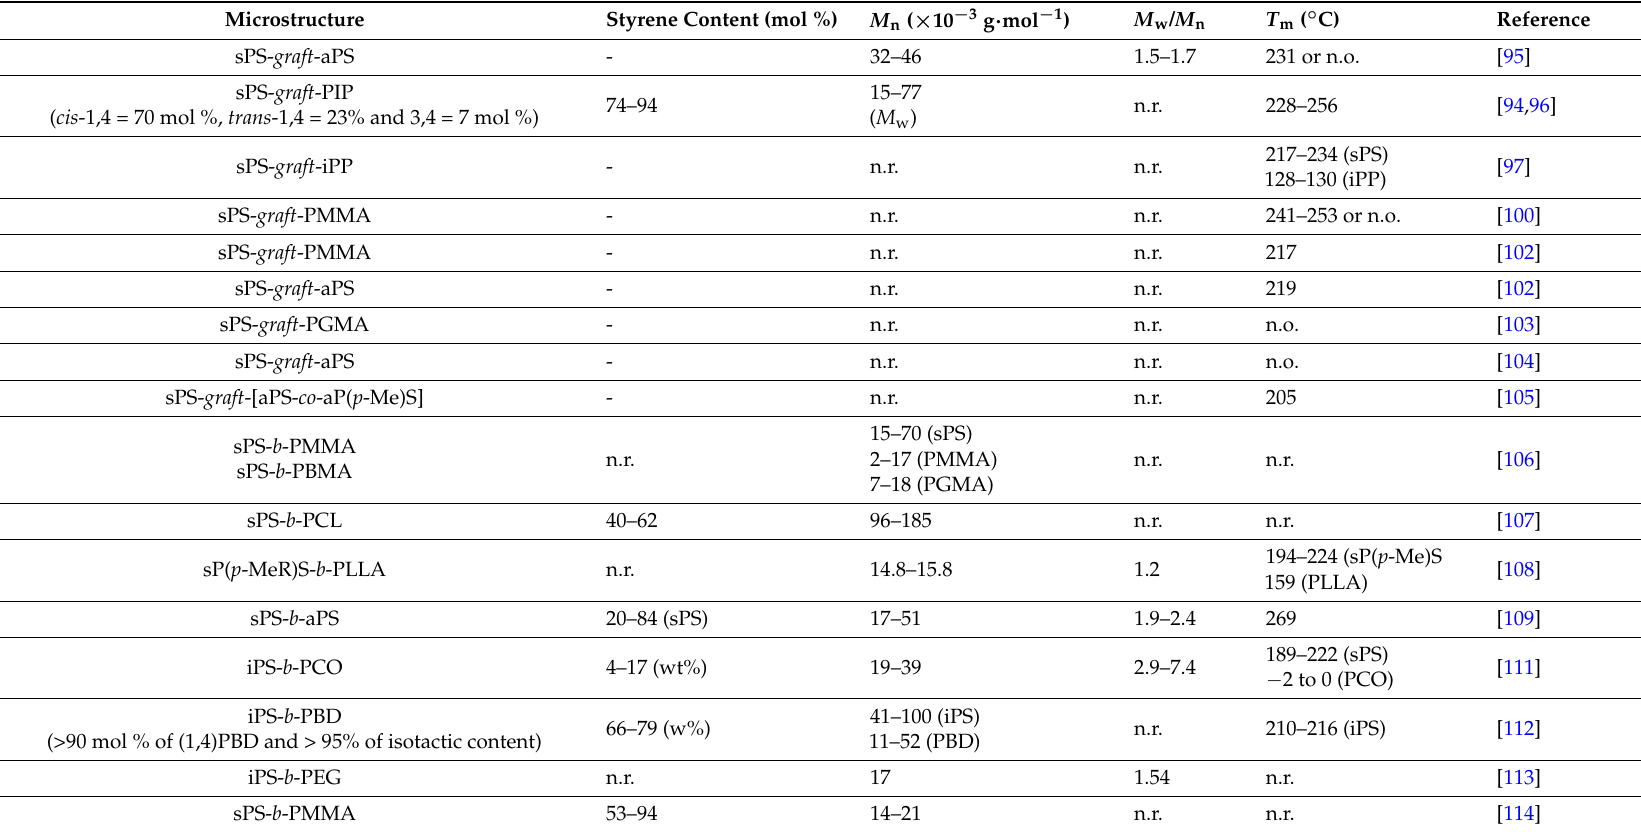
Table 7. Properties of graft and diblock stereoregular styrene